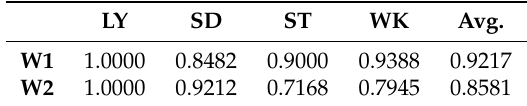
Figure 12. Confusion matrices for the classification results of the inertial measurement unit (IMU) sensor data: ( a ) W1; ( b ) W2. Table 5. F 1 accuracy of the classification results on the IMU sensor data.